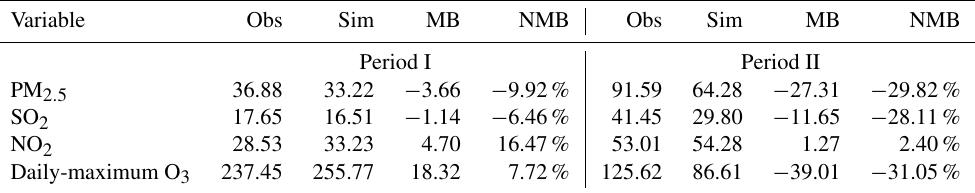
Table 3. Statistical evaluations of the model chemical performance. Variable Obs